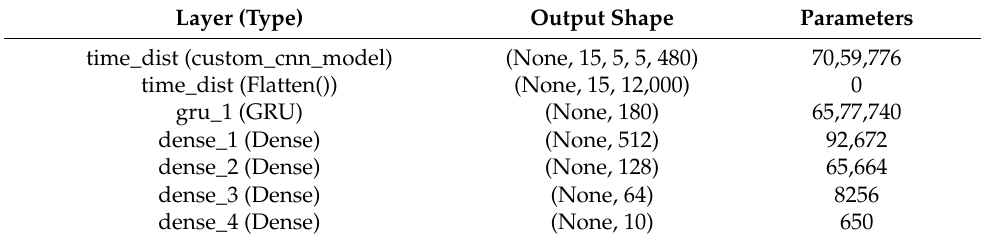
Table 2. Model architecture for custom